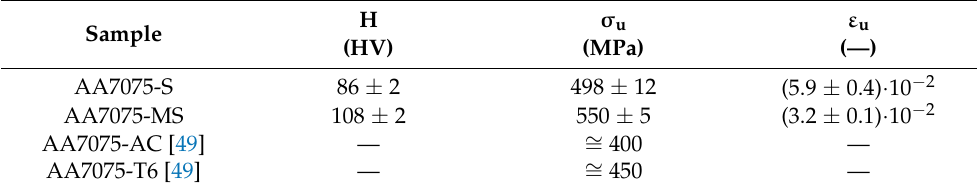
Table 3. Mechanical properties of the AA7075-S and AA7075-MS samples: Vickers microhardness